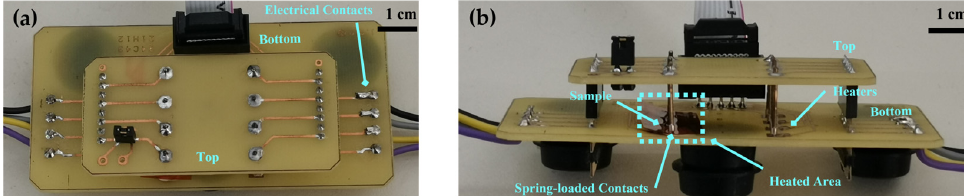
Figure 4. External thermal measuring experimental setup using Pt100 microheaters: ( a ) top view; ( b ) cross-section.